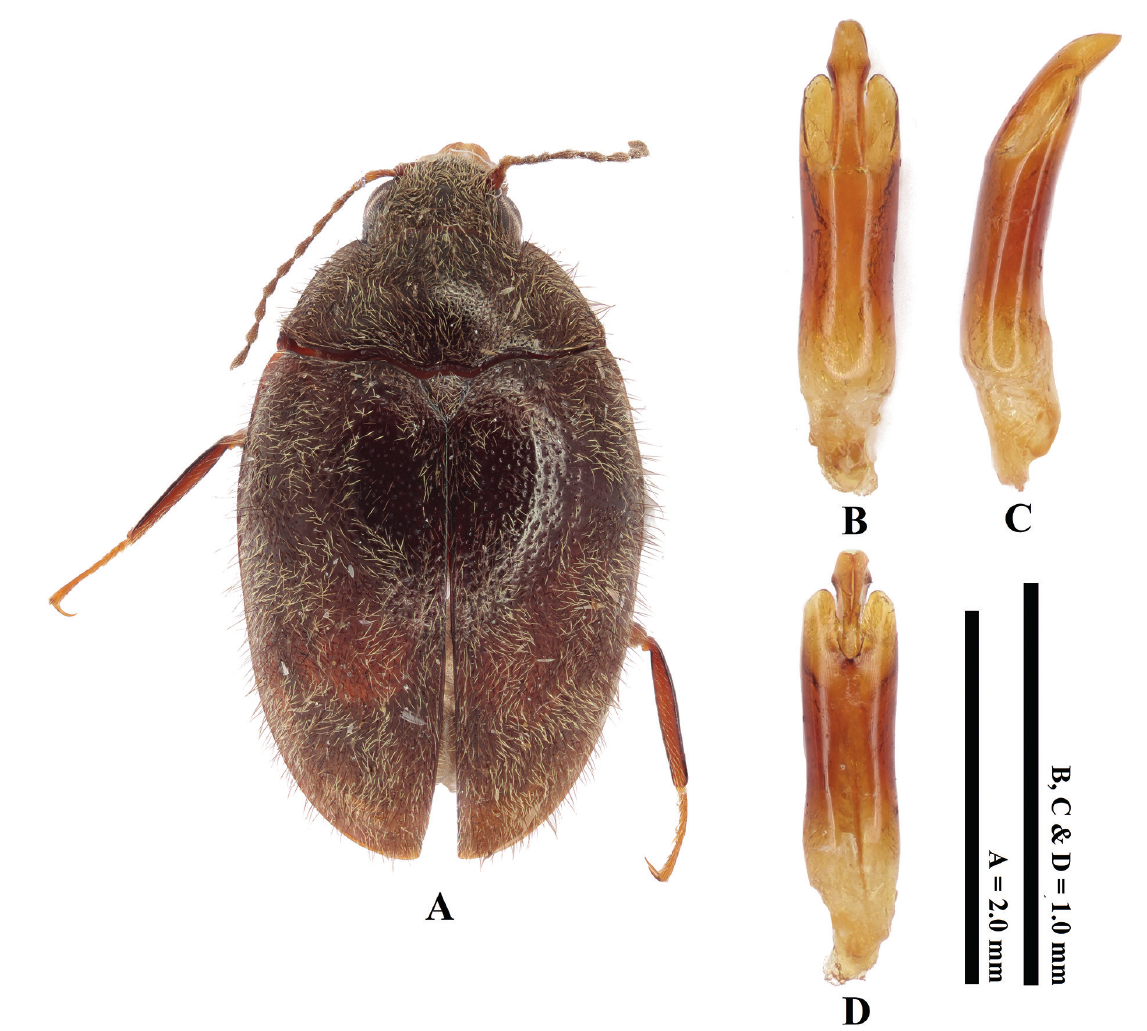
Fig. 4. Caccothryptus larryi sp. nov., ♂, holotype (NHMUK011225324). A . Dorsal habitus. B . Genitalia, dorsal. C . Genitalia, lateral. D . Genitalia,